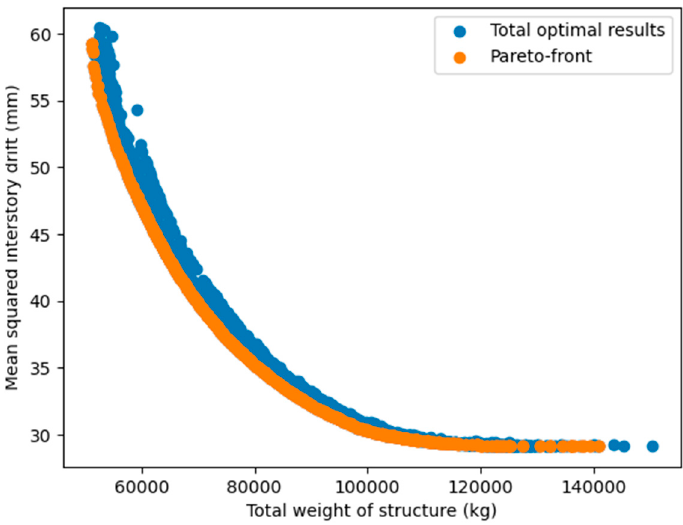
Figure 19. The approximate Pareto-front of the 113-bar truss bridge.